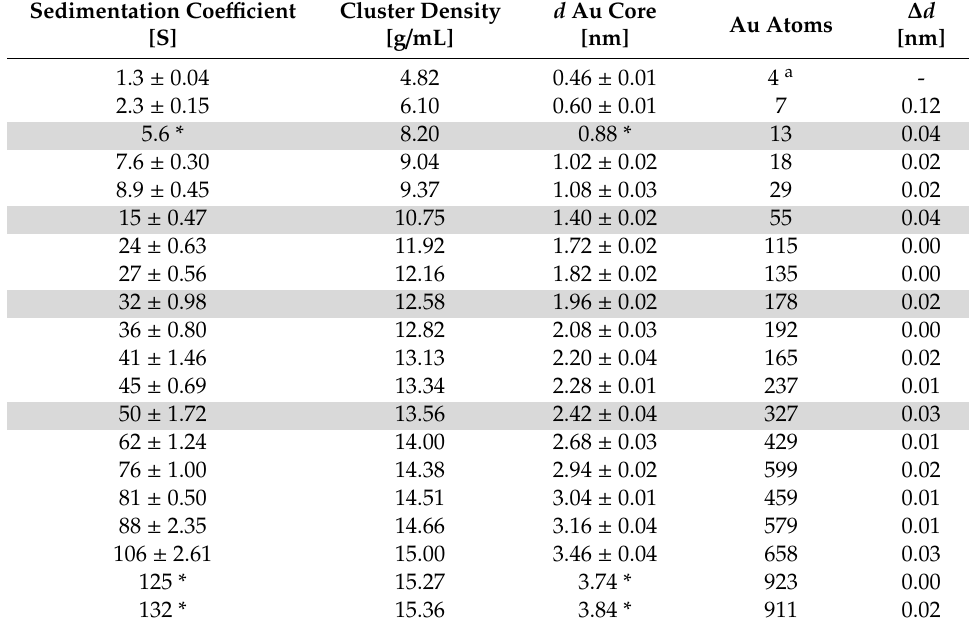
Table 4. Calculated sizes and atom numbers including the standard deviation for each cluster species found in di ff erent experiments of the nucleation of gold particles. The magic size clusters are marked in